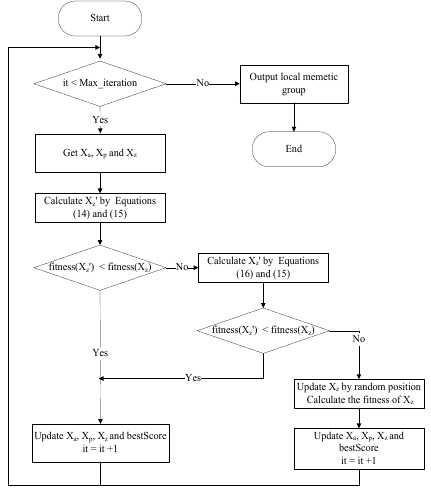
Figure 5. The flow chart of each